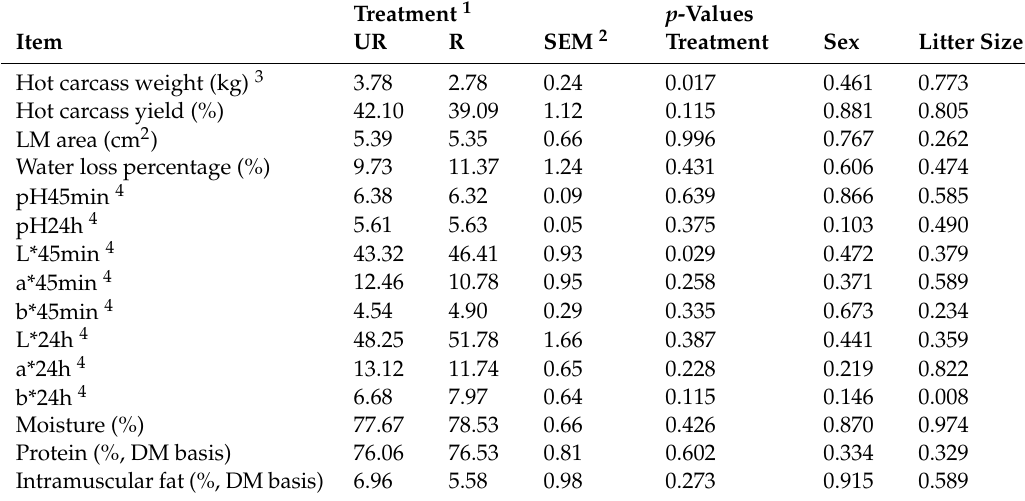
Table 5. E ff ects of maternal undernutrition during mid-gestation on carcass traits and meat quality in the Longissimus thoracis of kids at 90 d of